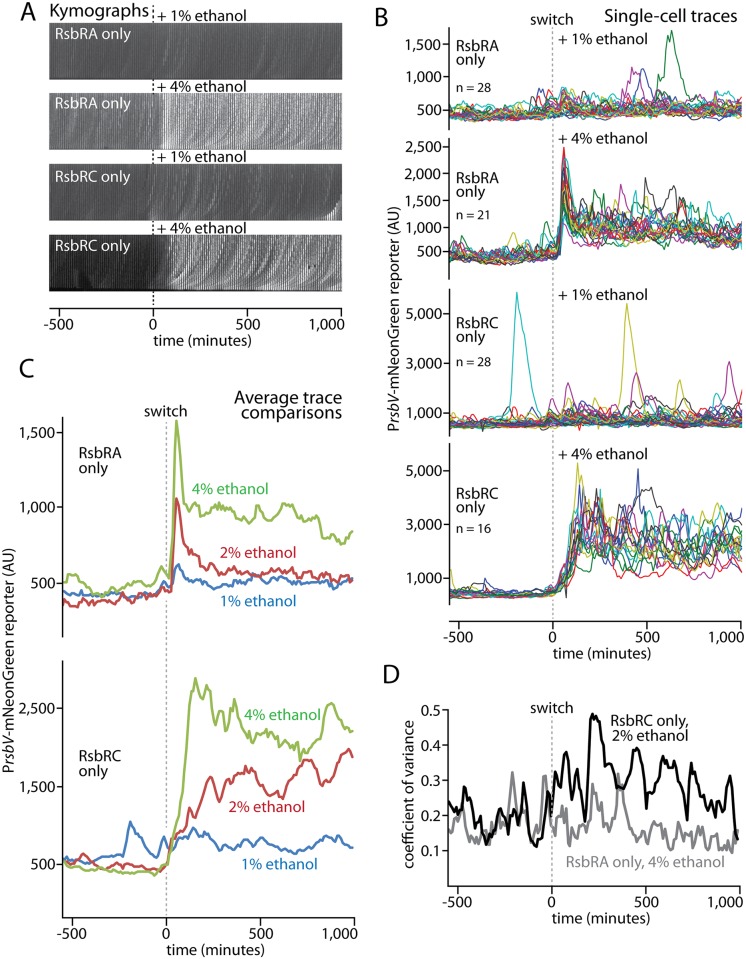
Responses of RsbRA- and RsbRC-only cells to different ethanol concentrations.A. Kymographs of individual cell lineages of strains containing RsbRA or RsbRC as the only RsbR in the cell (MTC1761 or 1765, respectively). Ethanol was added at the indicated concentrations at t = 0 (dashed lines). B. Single-cell intensity traces of a stress-responsive PrsbV-mNeonGreen reporter before and after (dashed line) the addition of ethanol at the indicated concentrations with the indicated strains. C. Overlaid average intensity traces of the cell populations in B showing different ethanol concentrations. The traces were manually curated to eliminate cell lineages with cell-death events or other anomalies; comparisons of mean traces for curated and uncurated populations are shown in S5 Fig. D. Coefficient-of-variance plot comparing the RsbRA-only strain at 4% ethanol with the RsbRC-only strain at 2% ethanol. The cell populations in B were used for the computation.